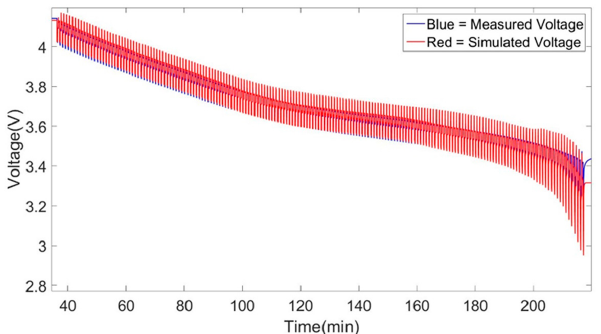
Figure 16. 2nd order Thévenin model measured and simulated DDP comparison at 25 °C with Coulomb counting and advanced characterization.